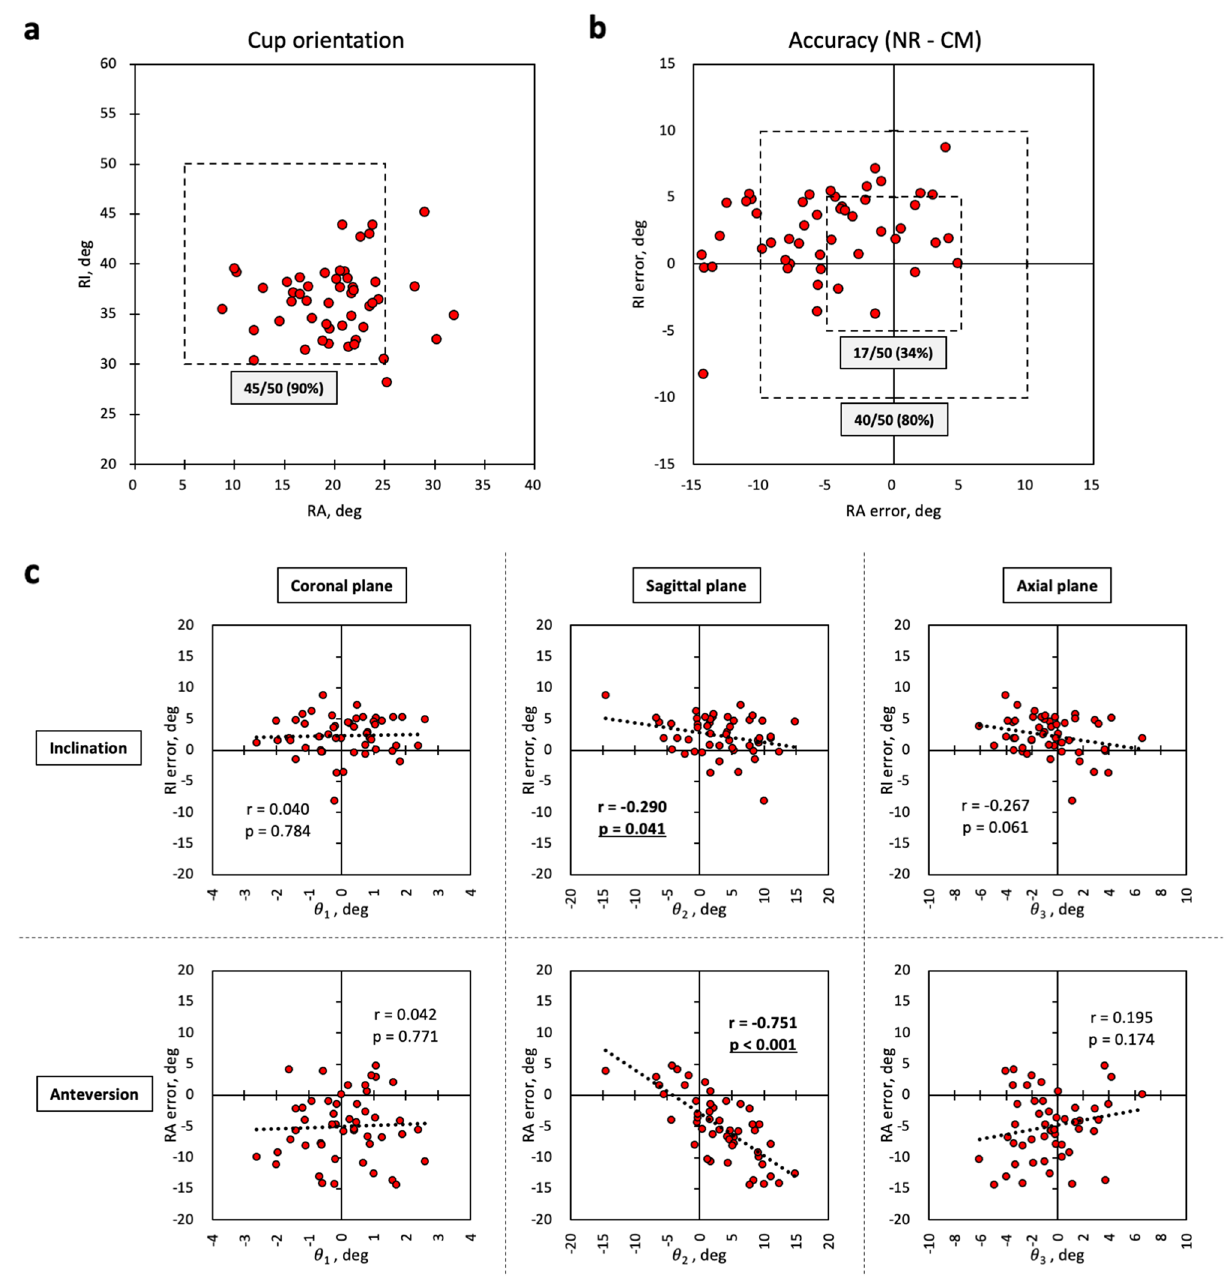
Figure 2. Accuracy of acetabular cup orientation, relationship between the cup orientation error and discrepancies in pelvic tilt. a Cup orientation, as measured by the postoperative CT images, and b accuracy of the portable accelerometer-based navigation system (HipAlign New Lateral Position). c The correlation diagram shows the relationship between RI/RA error and discrepancies in pelvic tilt in every plane. r is the correlation coefficient. The dotted square in ( a ) shows the Lewinnek safe zone. NR, navigation record; CM, CT measurement; RI, radiographic inclination; RA, radiographic anteversion; θ 1 , discrepancy in coronal pelvic tilt; θ 2 , discrepancy in sagittal pelvic tilt; θ 3 , discrepancy in axial pelvic